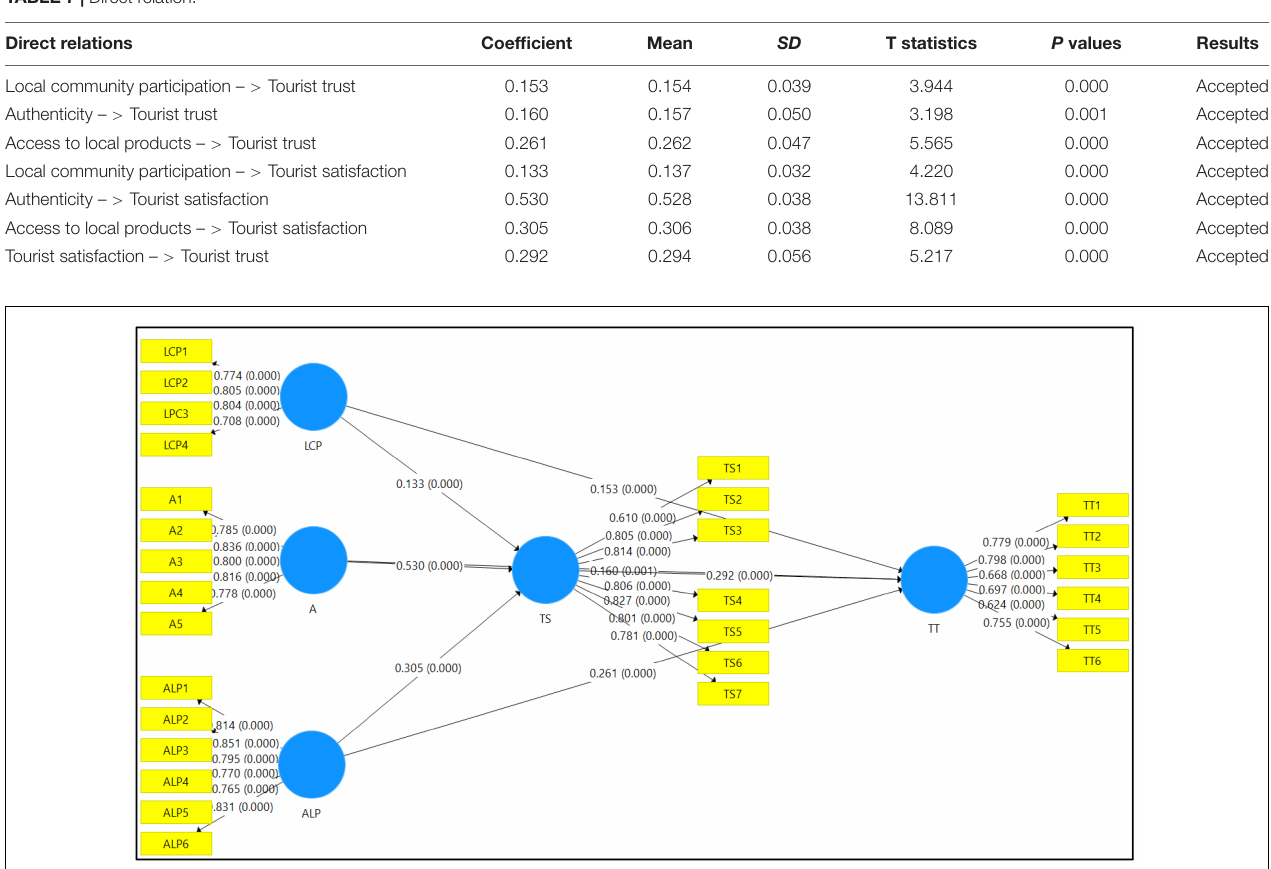
TABLE 7 | Direct relation.